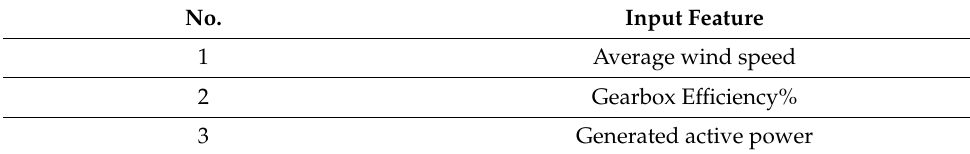
Figure 2. Ten minutes average sample simulated wind speed 2–18 m/s. Table 1. Selected input features of SCADA data.